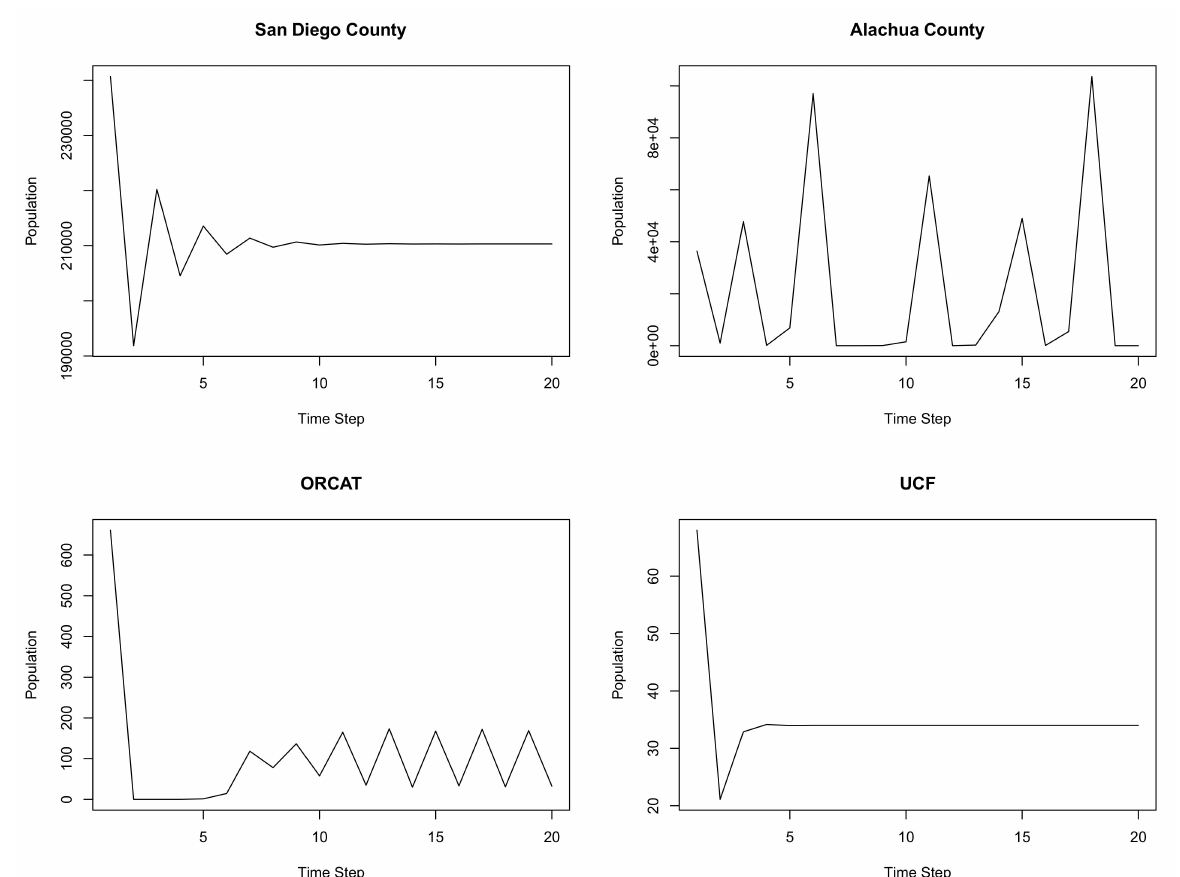
Figure 8. Ricker model simulation for San Diego and Alachua counties ( top ) and ORCAT and UCF programs ( bottom ). Time step is